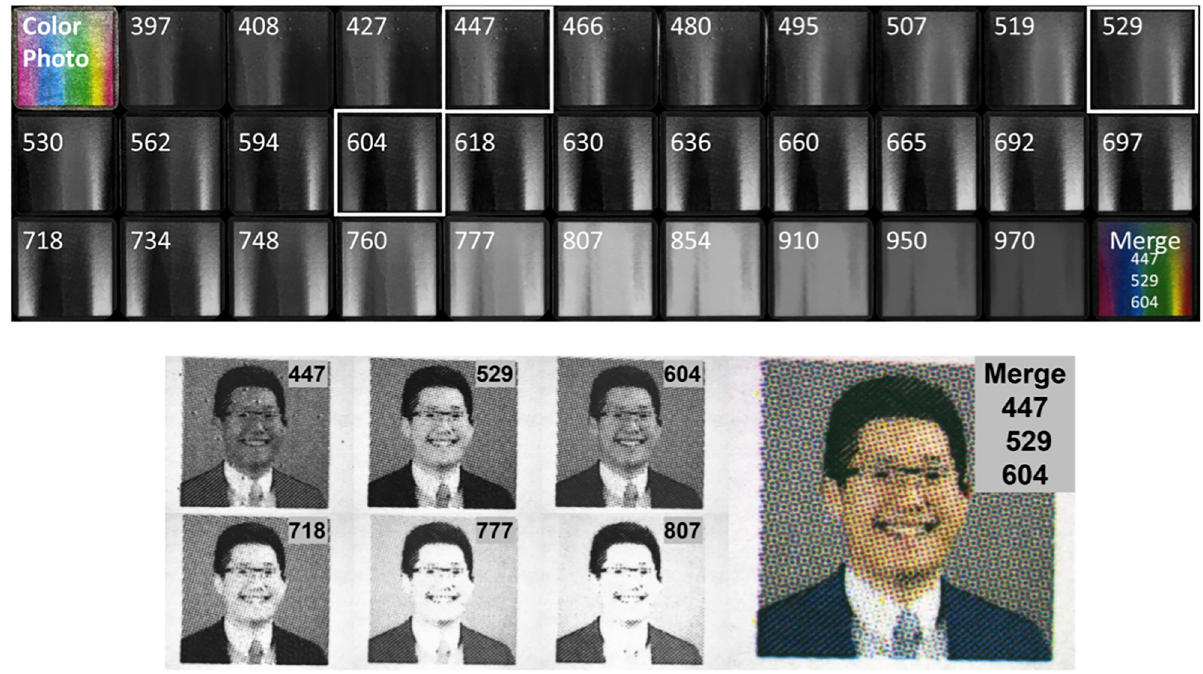
Fig 2. Sample images from the human portraits library. (top row) Spectral reflectance across 32 channels of printed a Windows color palette with color photo and merged channels 447, 529, 604. (bottom row) Spectral reflectance for 6 selected illuminant wavelengths and the visible spectrum color a photo created by merging channels 447, 529,